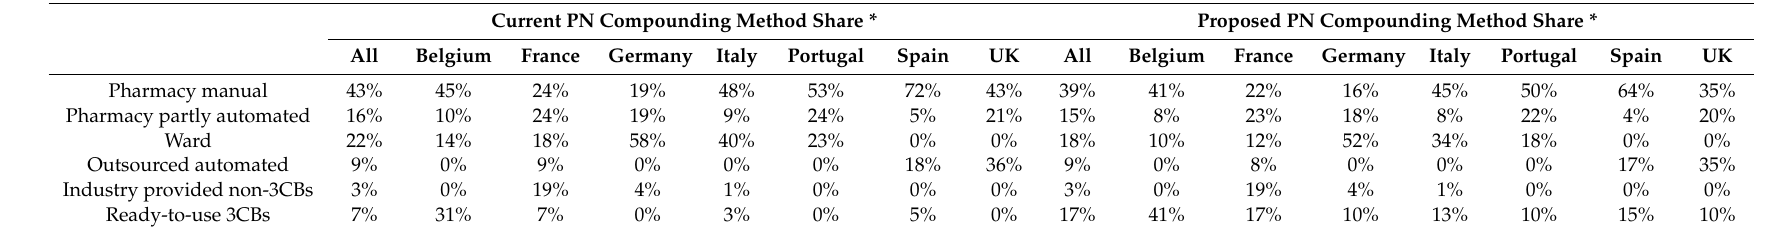
Table 1. Estimated current and proposed national PN Method Share Distribution.